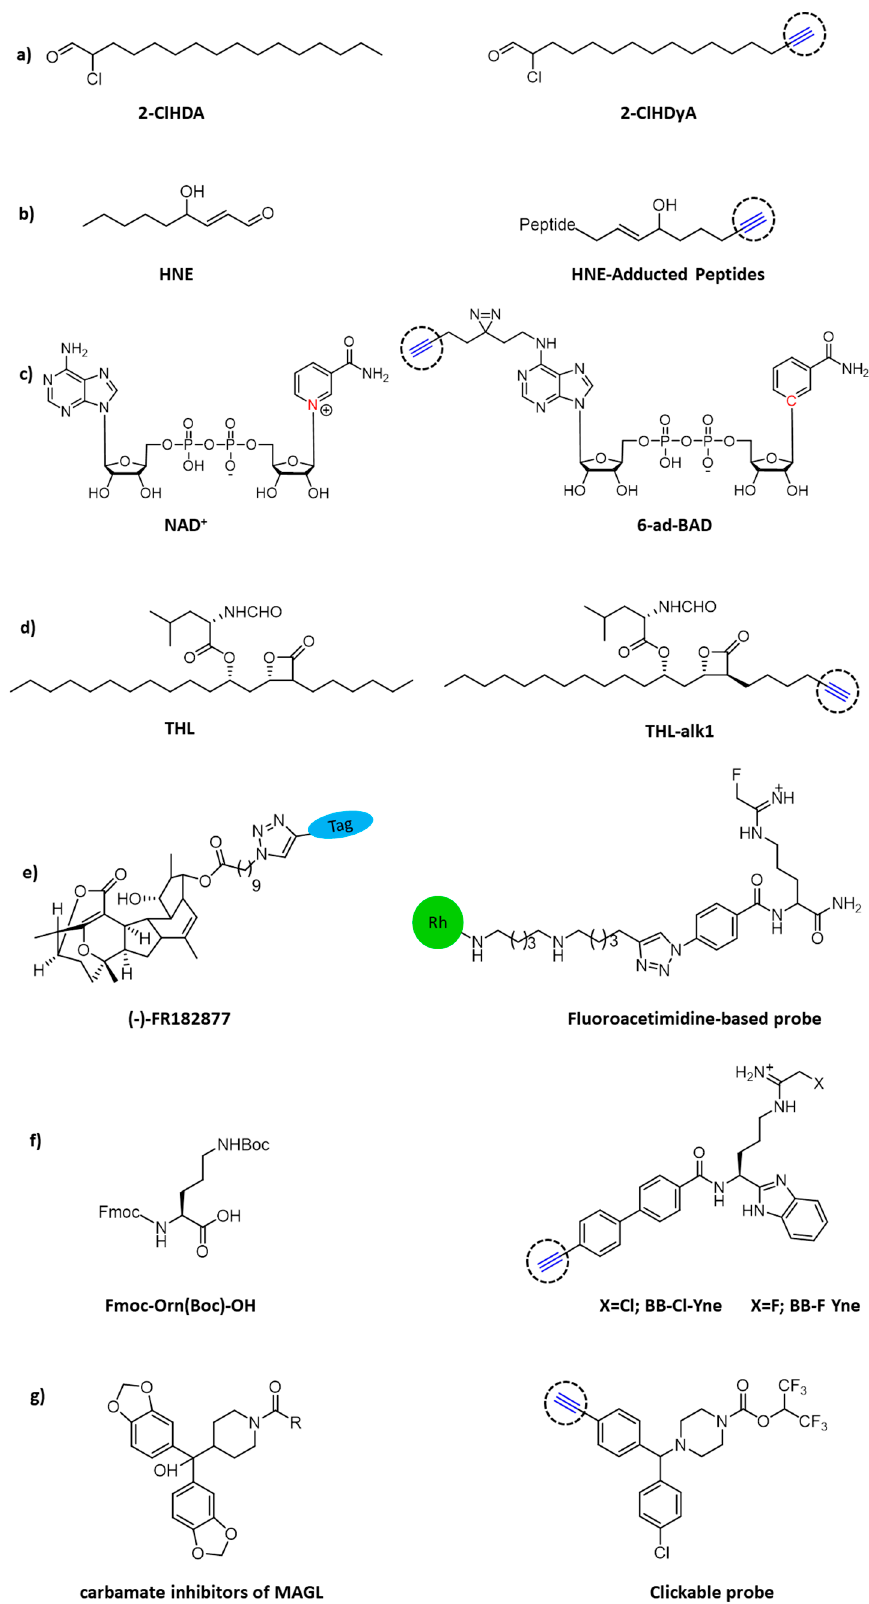
Figure 4. Chemical structures of clickable probes in ABPP for identifying protein targets of: ( a ) 2-ClHDA, ( b ) HNE, ( c ) NAD + , ( d ) THL, ( e ) natural product (-)–FR182877, ( f ) Cl- and F-amidine, and ( g ) carbamates.